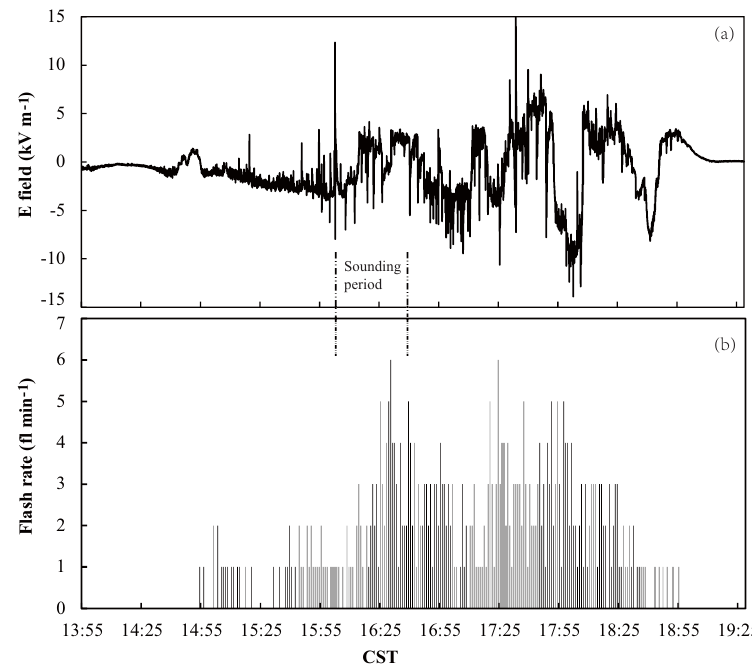
Figure 1. Evolution of surface E field and lighting flash rate of the thunderstorm. (a) Surface E field; (b) Flash